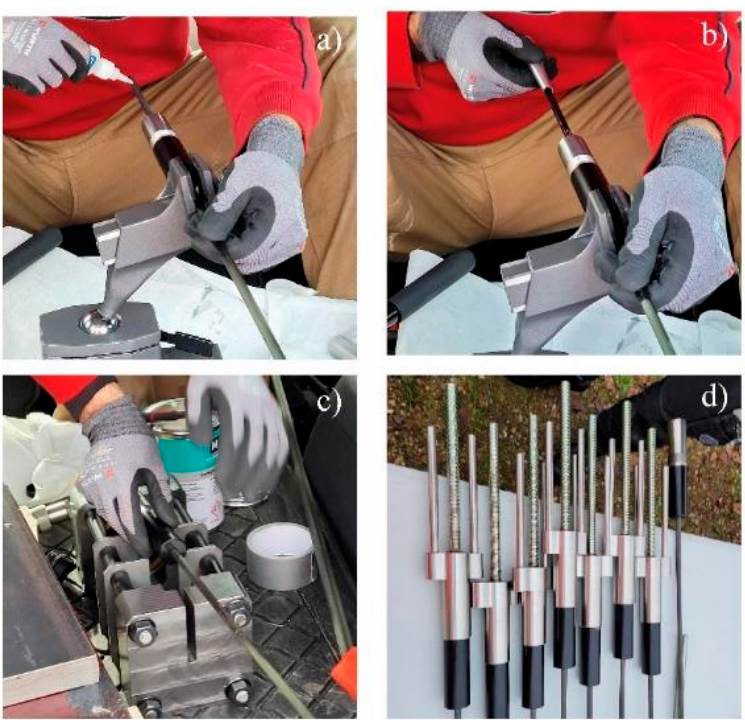
Figure 7. Assembling of the CFRP anchors. Photographs by the authors. ( a ) Grinding the CFRP surface and lubricating the surface with thin, liquid, and fast-curing glue. ( b ) Mounting of the wedge (viii) on the 8 mm CFRP rod in the lubricated area, which is then assembled with the barrel (ix). ( c ) Pre-setting of the wedge into the barrel using approximately 120 kN. ( d ) The coupler with inner threads (vii) was assembled with the threaded bar (v) as well as the end-threaded counteracting torque pins (vi) and screwed onto the threaded barrel (ix). Photographs by S&P.